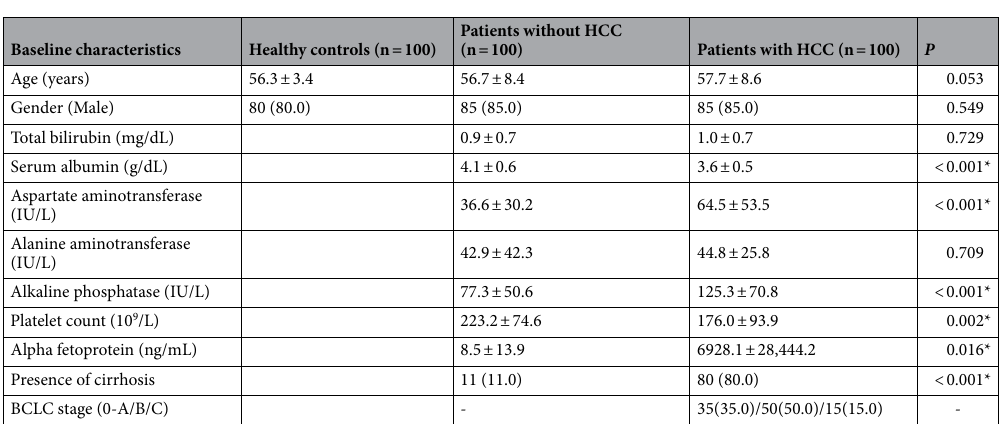
Table 1. Baseline characteristic of the validation